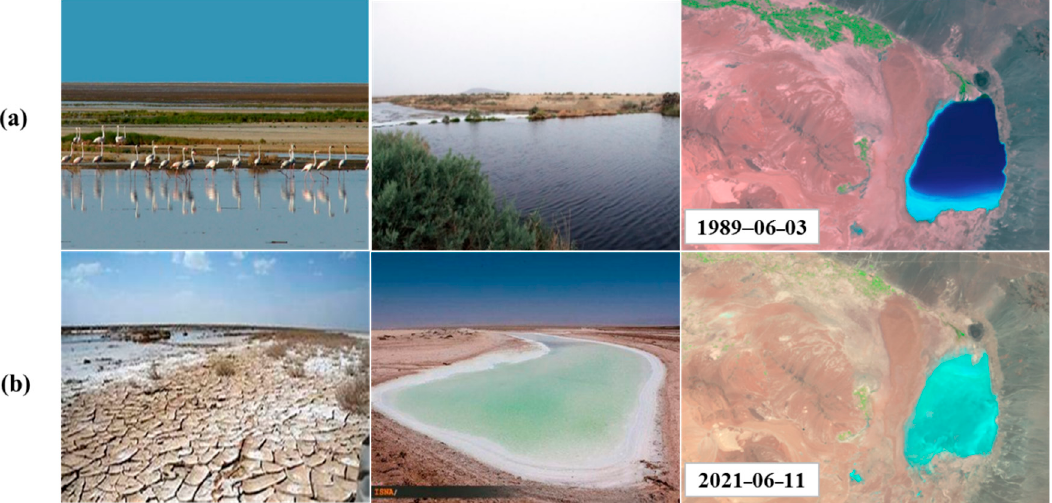
Figure 2. The situation of the Gavkhouni wetland: ( a ) in the past (before 2000); ( b ) at present.